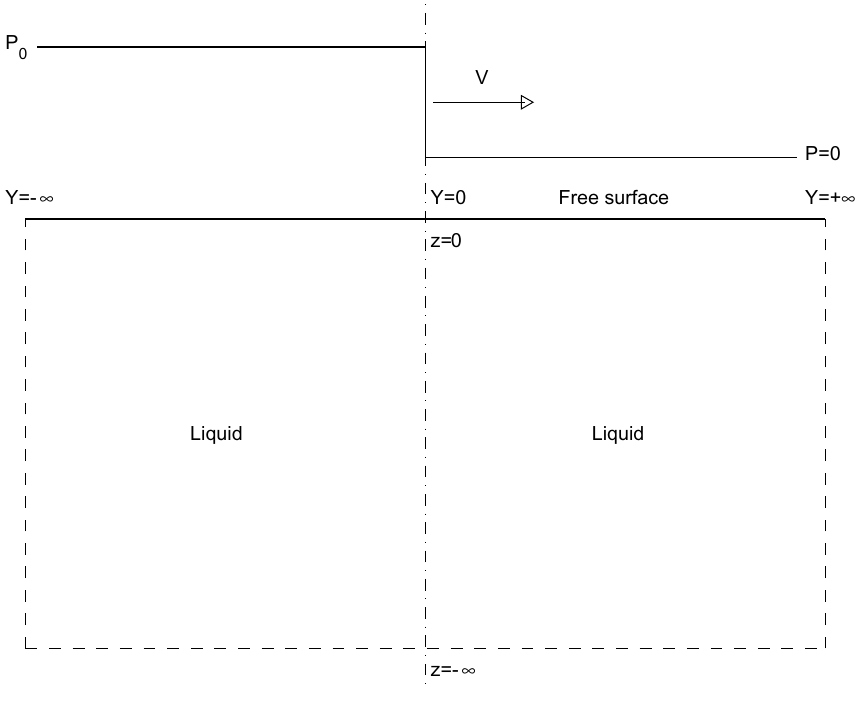
Fig. 1. The moving pressure step running on the